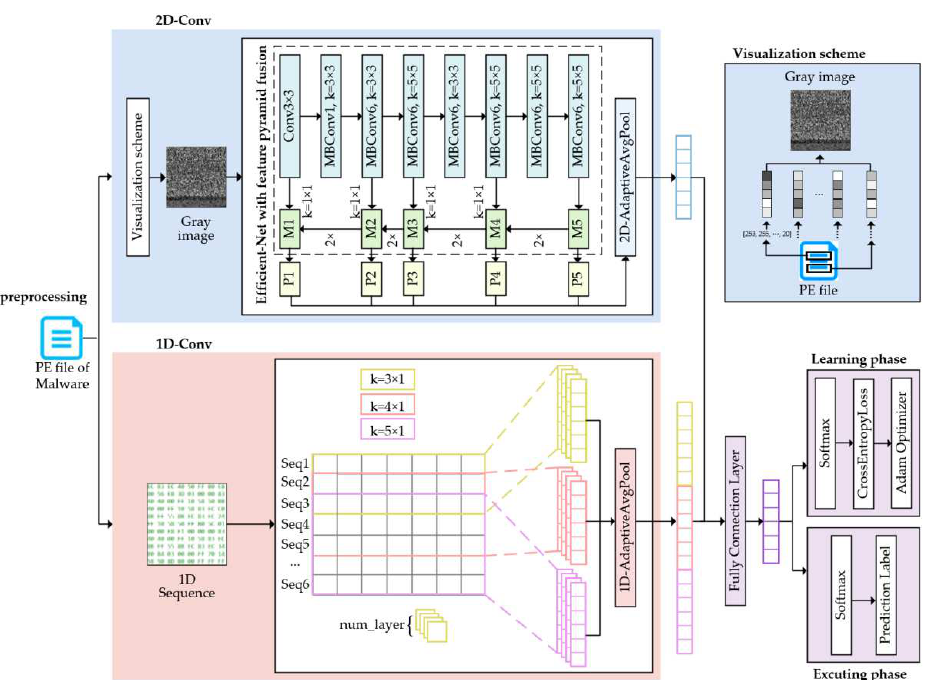
Figure 1. Model architecture diagram that combines Efficient-Net and 1D-CNN.